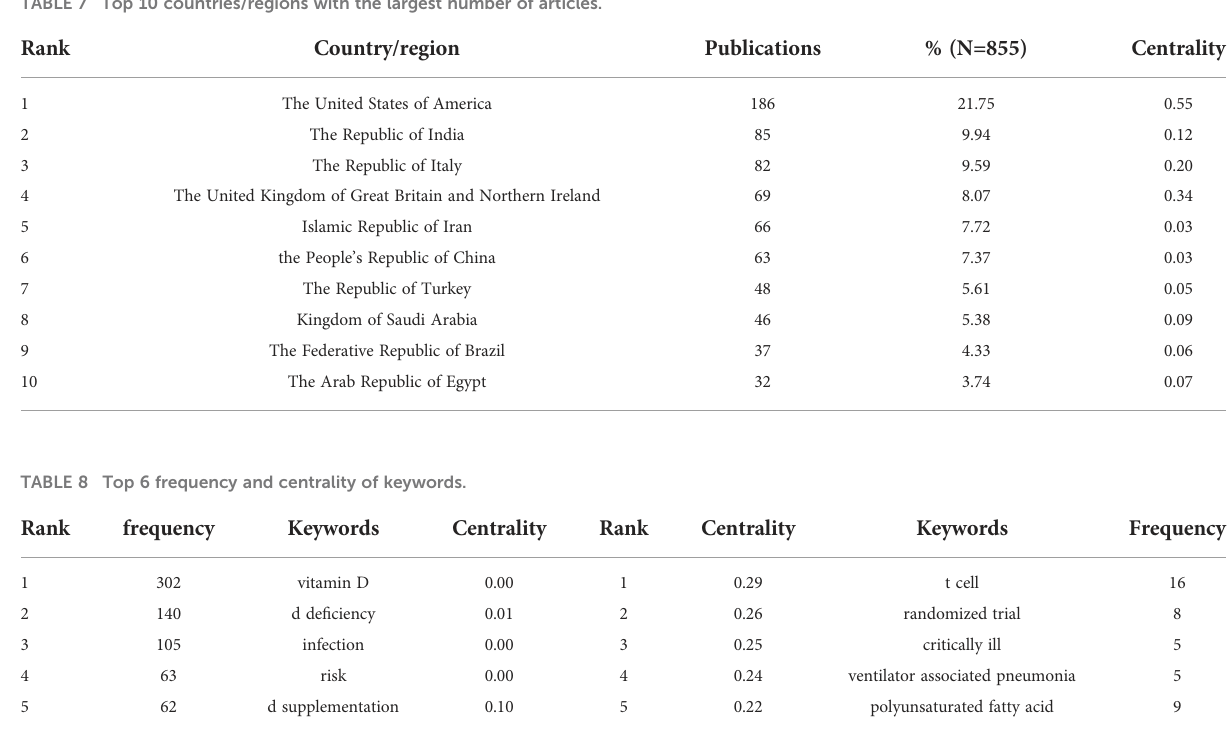
TABLE 7 Top 10 countries/regions with the largest number of articles.